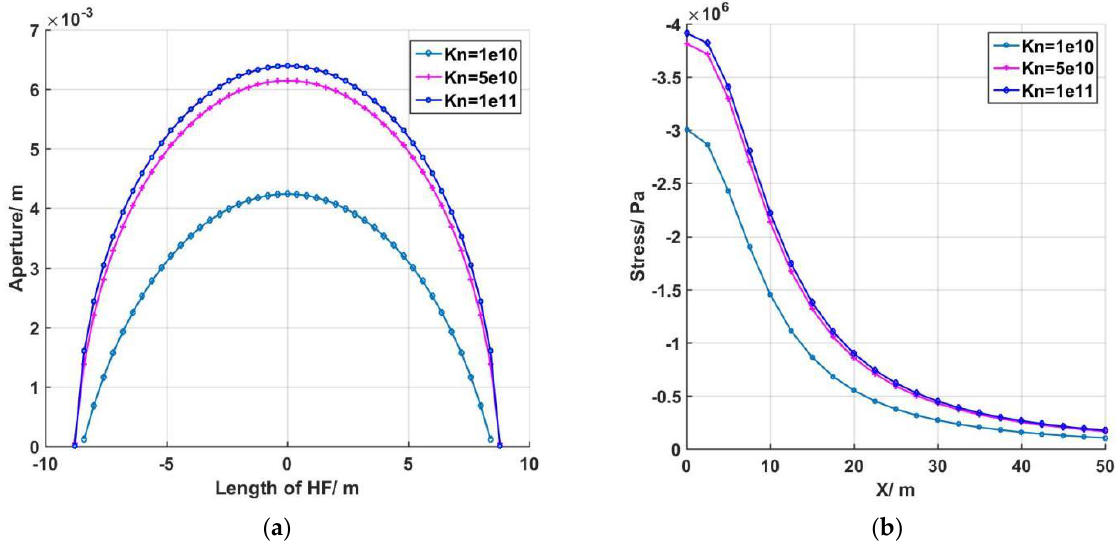
Figure 7. ( a ) Aperture of HF 1 with different stiffness; ( b ) induced stress near the fracture surface.